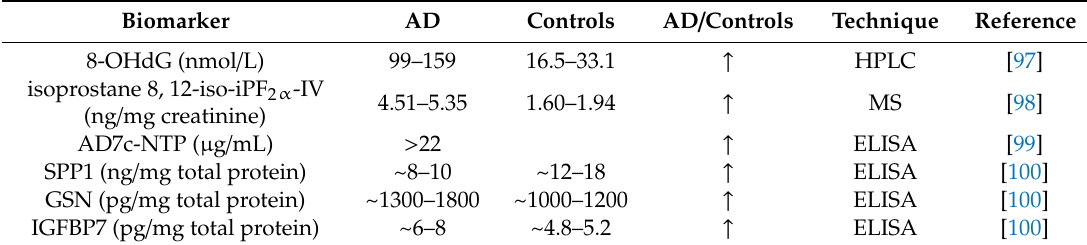
Table 4. Changes in levels of urinary biomarkers in AD patients and